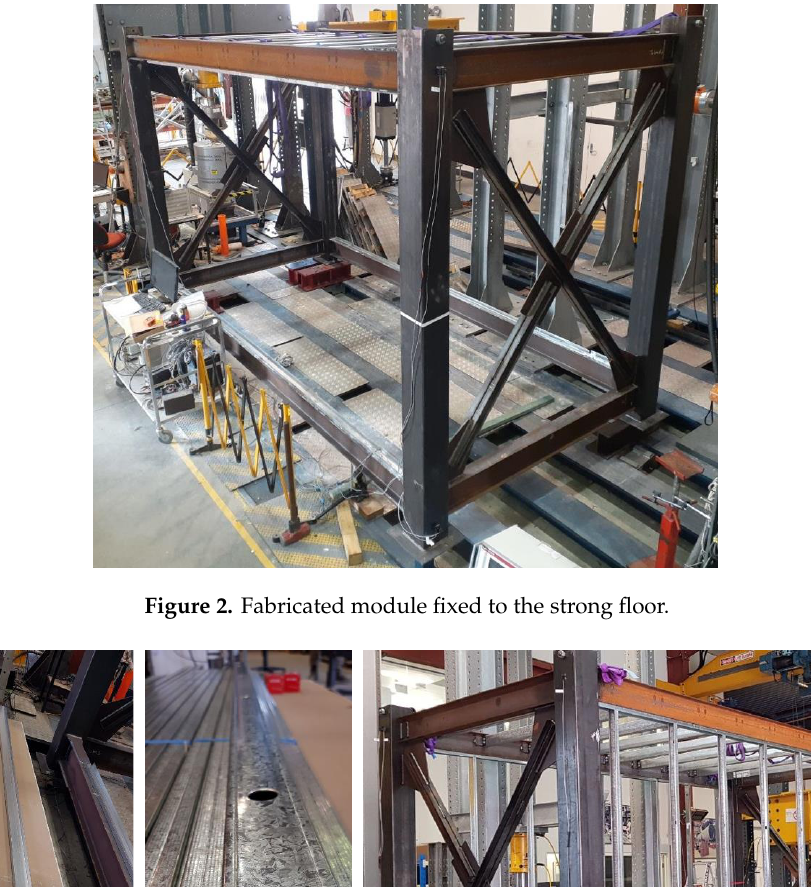
Figure 1. Design drawings of the steel module, all dimensions are in mm. ( a ) Long bay; ( b ) Short bay; ( c ) Pin connection; ( d ) Rigid connection; ( e ) Ceiling joist connection. All dimensions are in mm.